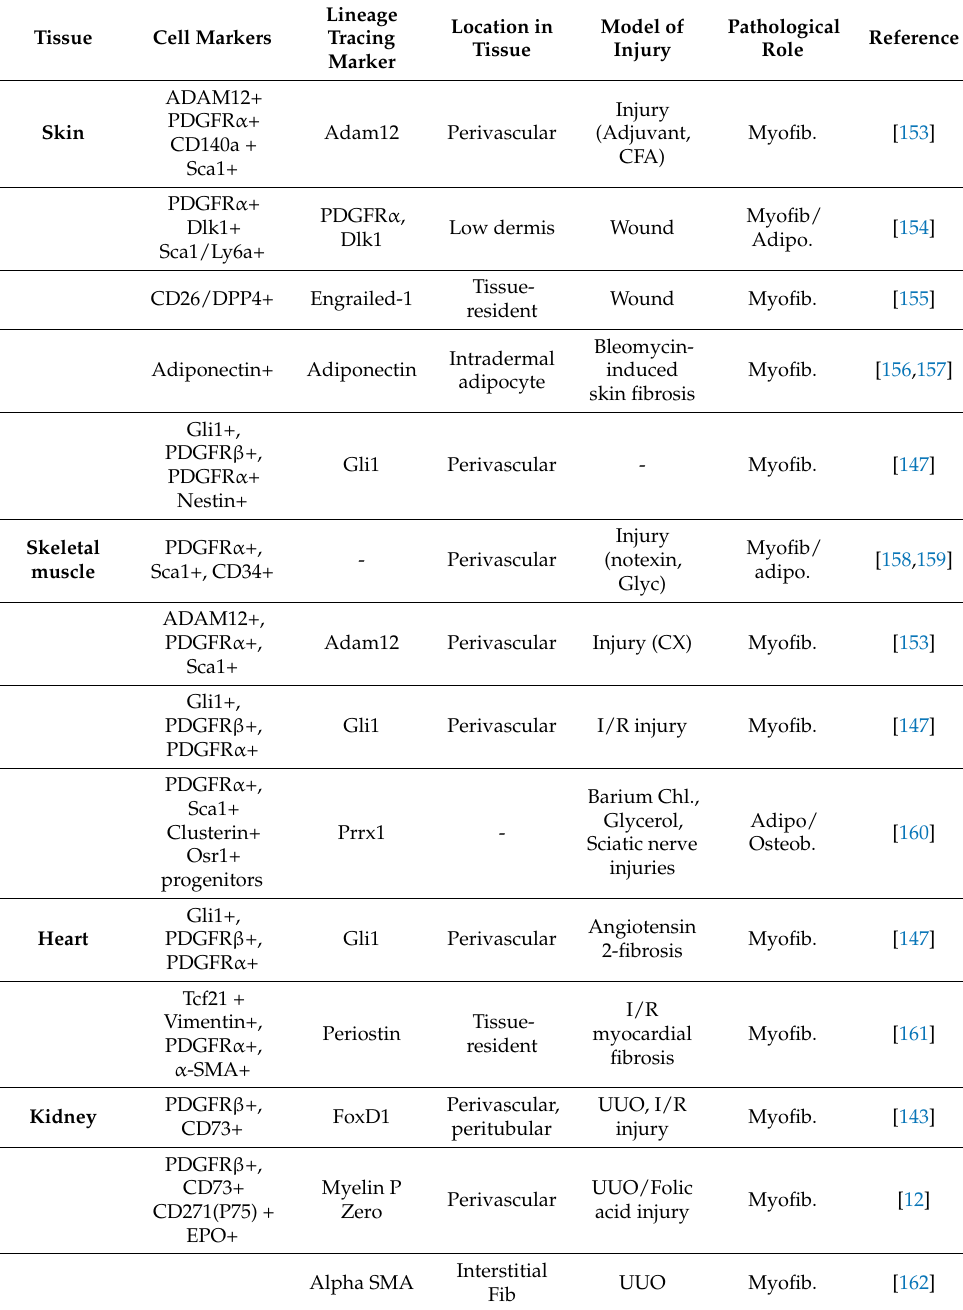
Table 2. Genetic lineage tracing and single-RNA sequencing studies to identify mesenchymal stem/stromal cells in all major organs in health and diseases. Adapted from [94,152]. Tissue Cell Markers